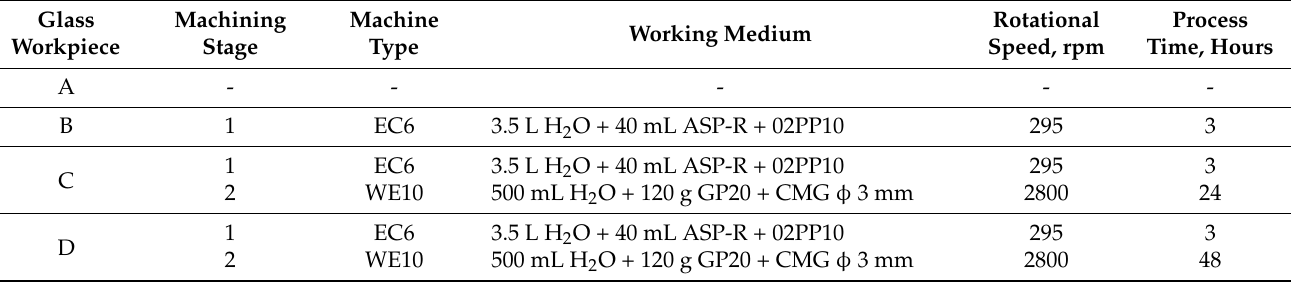
Table 7. Smoothing process